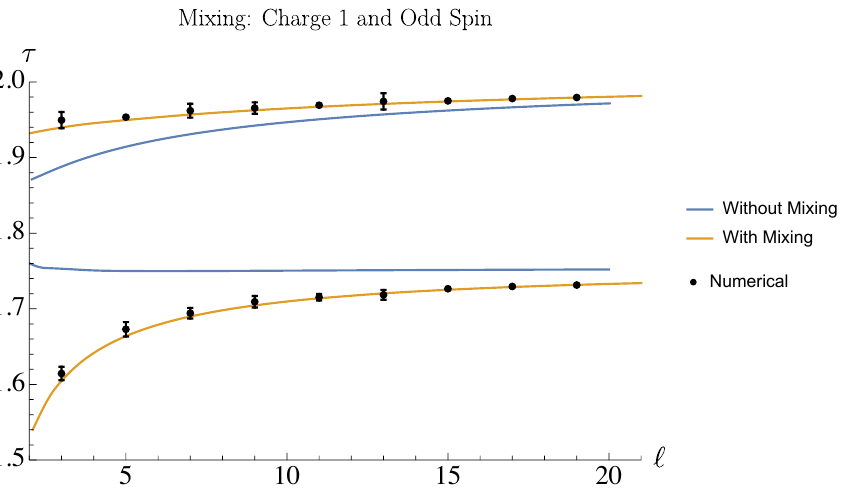
Figure 25 . A comparison between using or not using the twist Hamiltonian for the leading trajec- tories in the charge 1 odd-spin